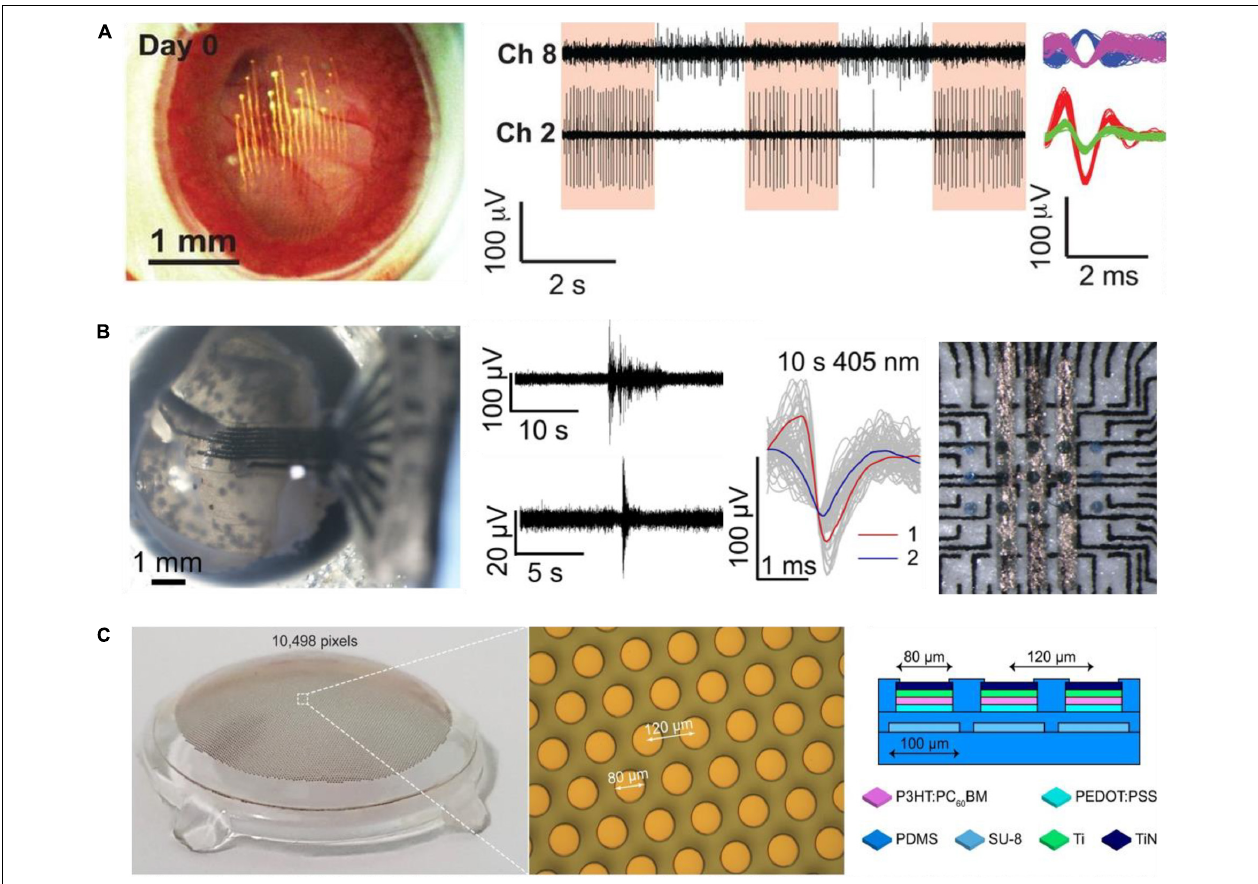
FIGURE 2 | Soft electrode arrays for electrophysiological studies in the intact retina. (A) Image of mesh electronics inside a mouse eye (left). RGC responses to light modulation recordings on day 14 after injection (middle). Sorted spikes assigned to different neurons (right). Adapted with permission from Hong et al. (2018). (B) Image of soft carbon probe placed inside an enucleated chick eye (left). Recorded spontaneous activity and responses to light stimuli (middle). Soft carbon MEA with organic photo-capacitors (230 mm) for bi-directional electrophysiology. Adapted from V˙ebrait˙e et al. (2021). (C) Wide field photovoltaic retinal prosthesis. Adapted from Chenais et al. (2021b). Copyright© 2021, The